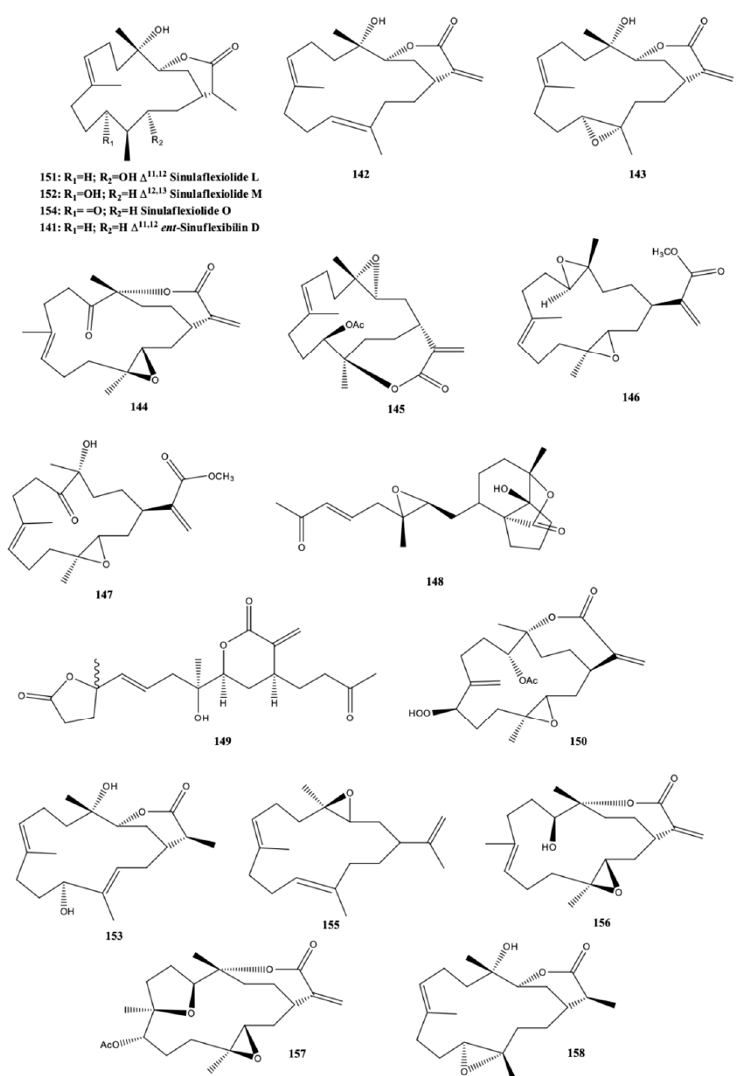
Figure 14. Cembranoid diterpene-derivarives from Sinularia flexibilis from the South China Sea (Sanya Bay, Hainan Island; Mantanani Island, Sabah; Megalum Island, Sabah; Yongxing Island, Coast of Liuqiu, Taiwan) [39,44–46]. 5-Dehydrosinulariolide and 11-dehydrosinulariolide have the same number, because the chemical structure found in the references is the same for both names.